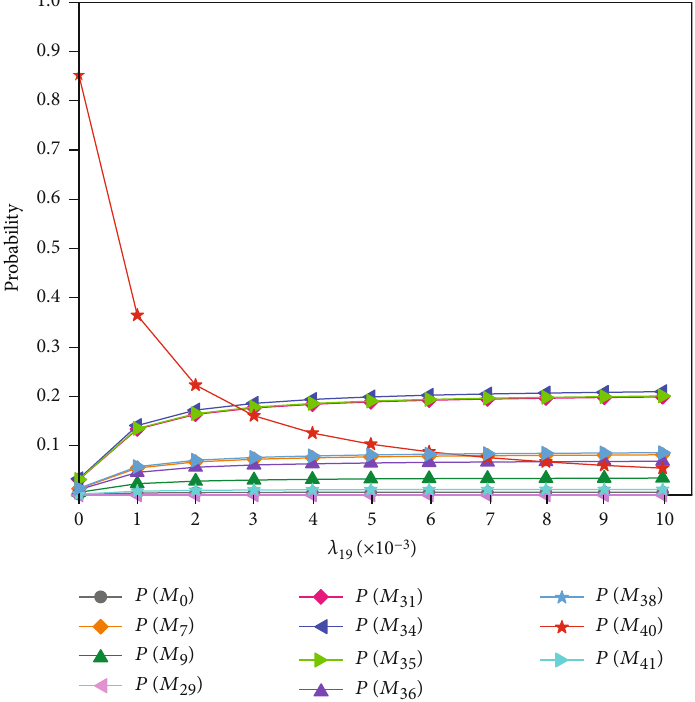
Figure 10: Variation of system probability with change in λ